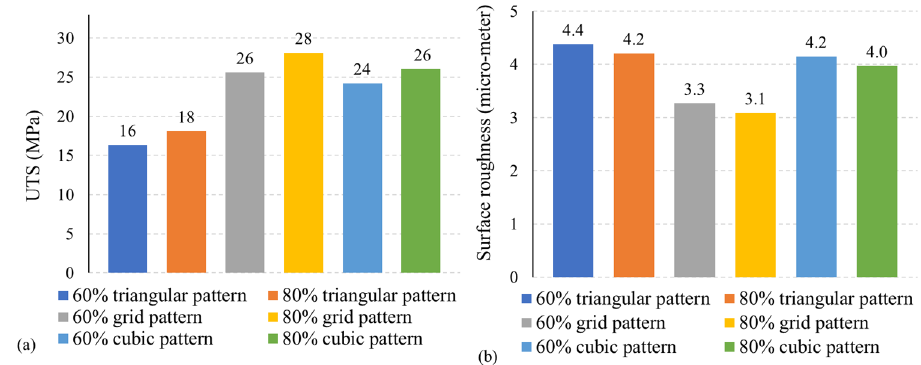
Figure 19. Effects of infill percentage with different pattern shapes on ( a ) UTS and ( b ) surface rough ‐ ness.